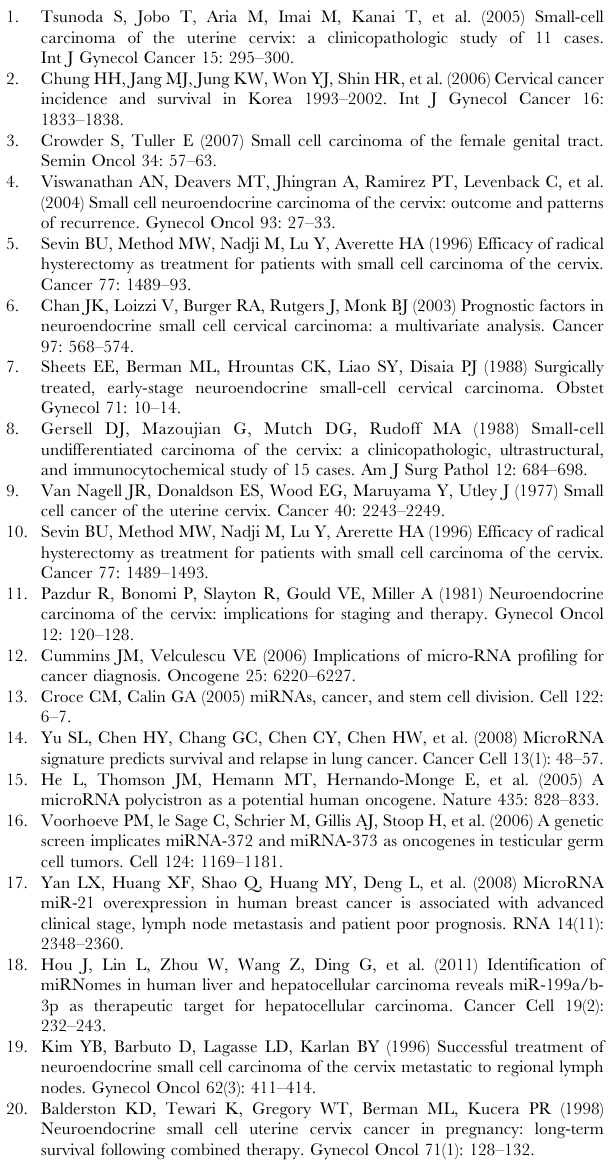
Table S2 MicroRNA Fold Changes in Small Cell Carcinoma of the Cerxix Detected Using a qPCR Primer Array Detection